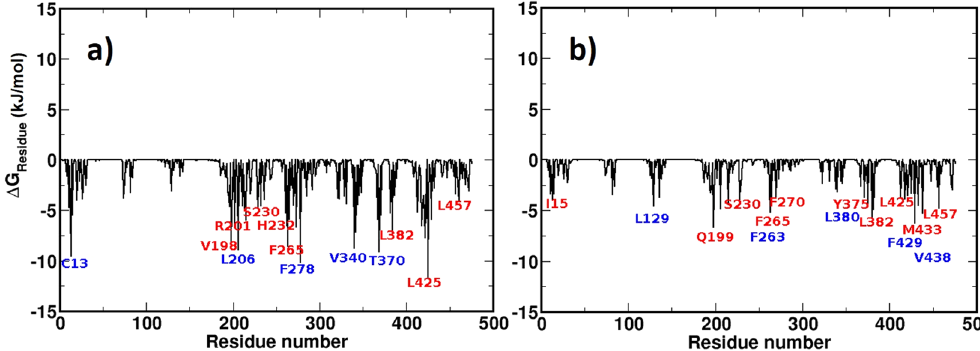
Figure 8. Gibbs free energy of binding of individual CETP residues with ( a ) TG molecules in CETP-TG complex and ( b ) CE molecules in CETP-CE complex. Residues that exhibited diminished lipid transfer activity upon mutations, in recent mutagenesis studies, are labeled red and the other important residues are labeled